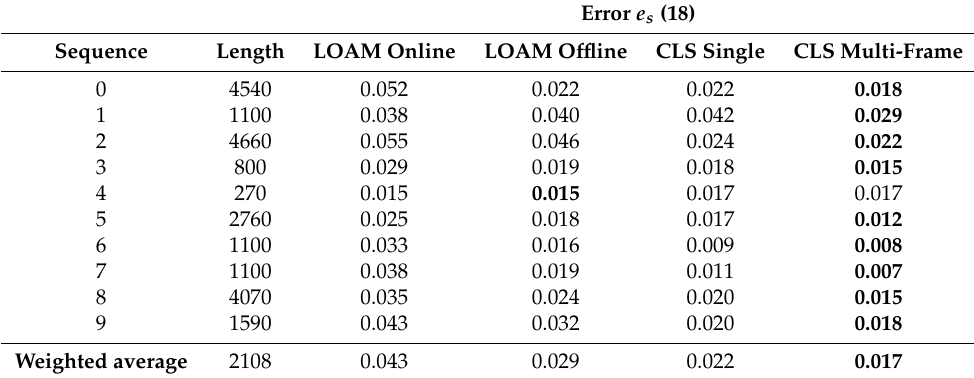
Table 2. Comparison of visual odometry error for SoA method LOAM and our CLS method. The experiments were performed on KITTI Odometry dataset [22]. For CLS, frame to frame (single) or frame to multiple (10) neighboring frames (multi-frame) registrations without any loop closures were performed. In LOAM experiments, both the original online version (providing real time performance) and offline version (with full procedure for each frame omitting approximations) was used. In all data sequences, except the short sequence No. 4 where the car drives only forward without any turns, our multi frame approach outperformed the LOAM solution.